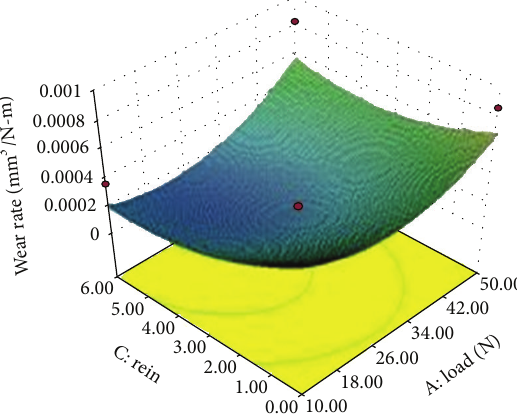
Figure 7: Variation of wear rate of Al-Gr composites with varying load and graphite content.